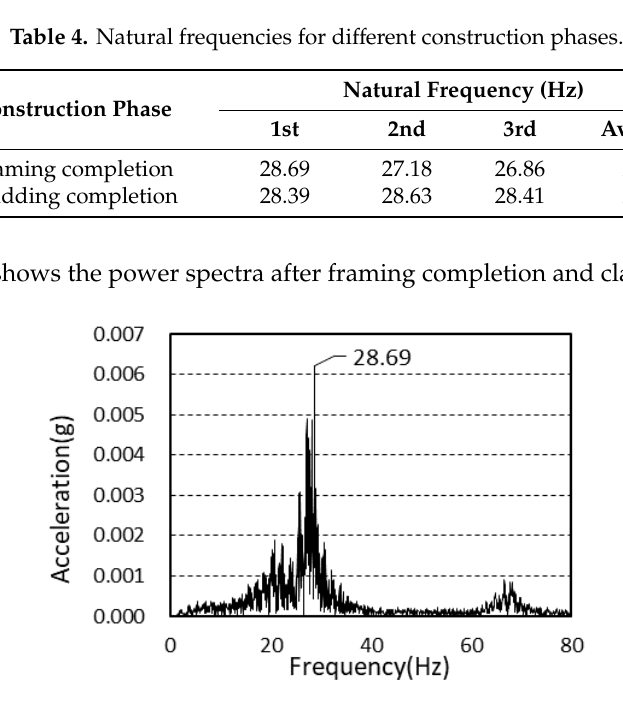
Figure 7. Power spectrum (cladding completion). 4.1.2. Damping Ratio To calculate the damping ratio of the floor, the first mode of the free-vibration time-series waveform was used, as shown in Figures 8 and 9. Figure 8. Damping ratio (framing completion).